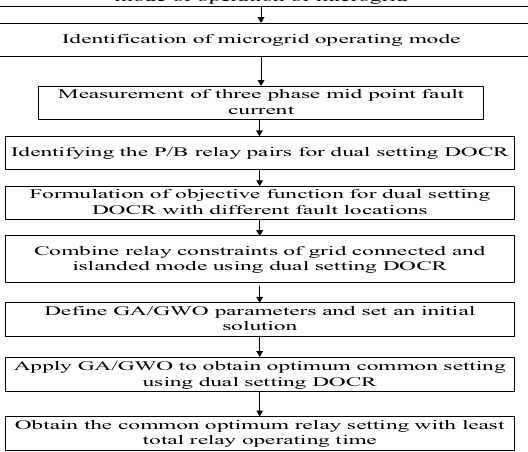
Fig. 9 Method for common optimal setting for dual operating modes of